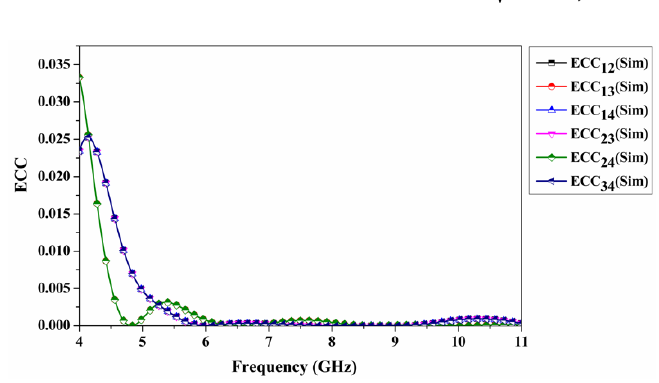
Figure 10. Simulated envelope correlation coefficient of quad-port